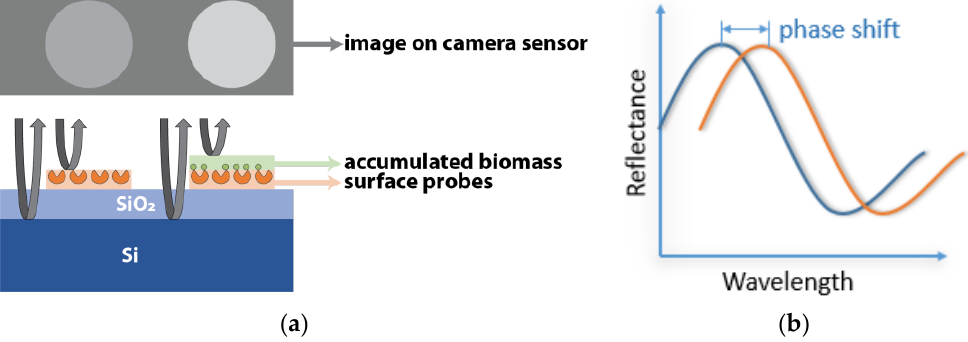
Figure 2. IRIS working principle; ( a ) demonstration of biomass accumulation on the sensor surface and ( b ) the resulting change in reflectance of the film.